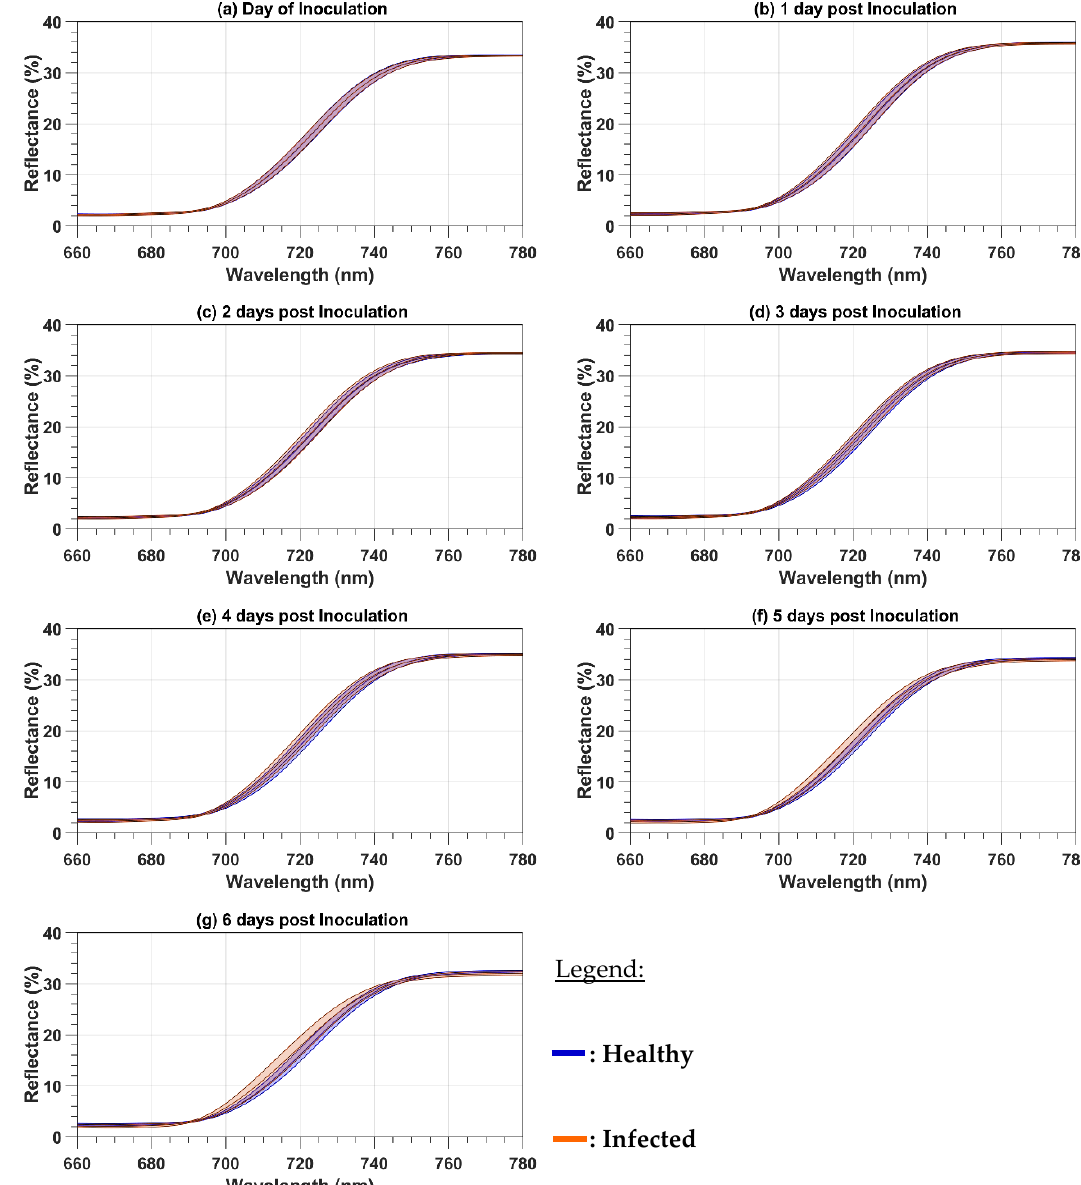
Figure 4. Comparison between healthy and infected canopies for the mean reflectance spectra (with one standard deviation) in the red region (660 to 680 nm) and red-edge region (680 to 780 nm) as a function of the number of days post-inoculation ( a – g ).